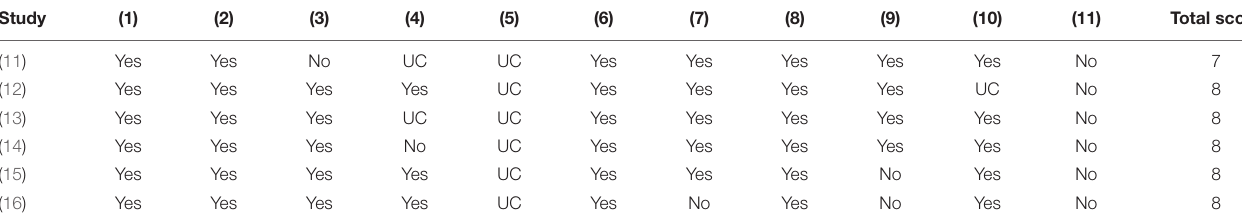
TABLE 3 | Quality assessment of included 6 cross-sectional studies with Agency for Healthcare Research and Quality (AHRQ) assessment tool. Study